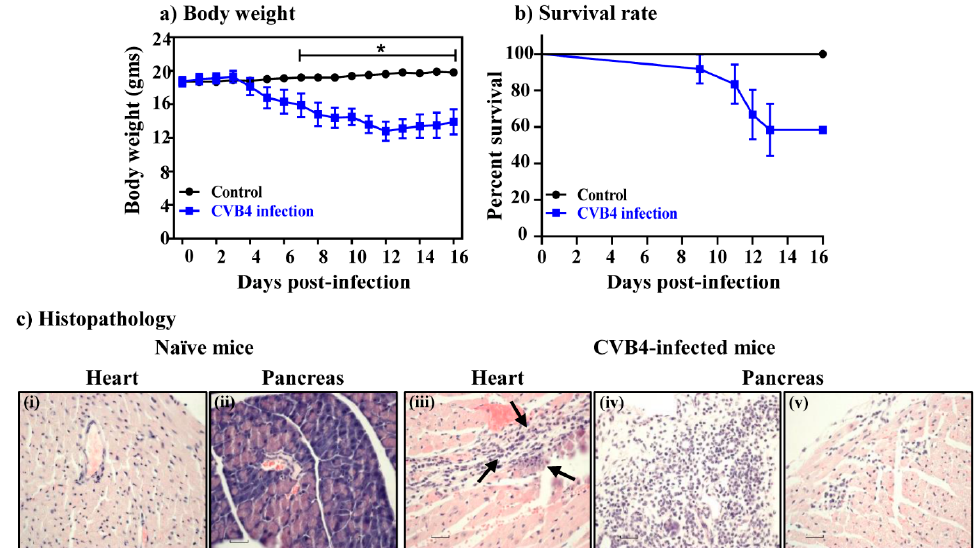
Figure 5. Evaluation of disease severity induced with CVB4 in A / J mice. ( a ) Body weight. A / J mice were infected with or without CVB4 and their body weights were noted up to 16 days post-infection. ( b ) Survival rates. The above mice were monitored for mortality post-infection and their survival rates were calculated. Data from two individual experiments, each involving four to eight mice are shown. ( c ) Histopathology. Hearts and pancreata collected at termination on day 16 post-infection with CVB4 were evaluated for inflammatory changes. While, heart (i) and pancreatic (ii) sections from control group were normal, sections from CVB4-infected mice had hemorrhagic necrosis, fibrosis, mineralization and inflammation in heart (iii), and atrophy (iv) and inflammation (v) in the pancreas. Original magnification, × 40. Representative data from the above experiments are shown. * p ≤ 0.05. Table 2. Histological evaluation of hearts and pancreata in naïve and CVB4-infected mice. Parameters Naïve CVB4 Heart Incidence 0/4 (0.0) 4/12 (33.3) Mortality 0/4 (0.0) 5/12 (41.7) Myocardial lesions 0.0 (0.0) 10.0 ± 1.2 Pancreas Incidence 11/12 (91.7) Atrophy 10/12 (83.3) Inflammation 0 (0.0) 6/12 (50.0) Necrosis 0 (0.0) Mineralization